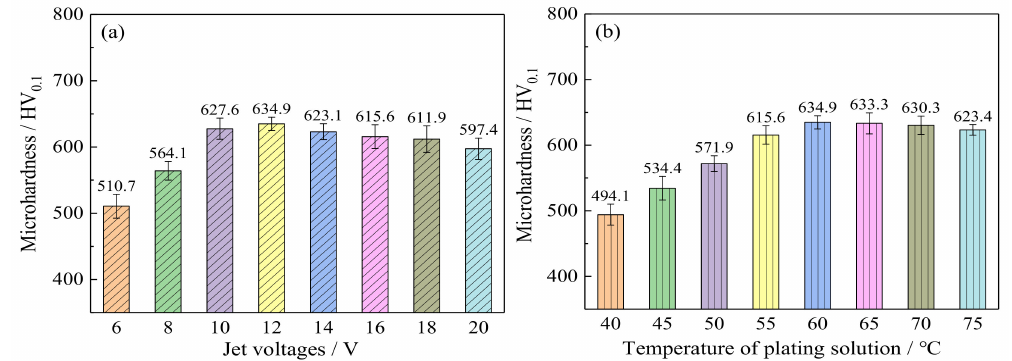
Figure 6. Microhardness of Ni–Co–P alloy coatings as a function of: ( a ) jet voltages; ( b ) the temperature of plating